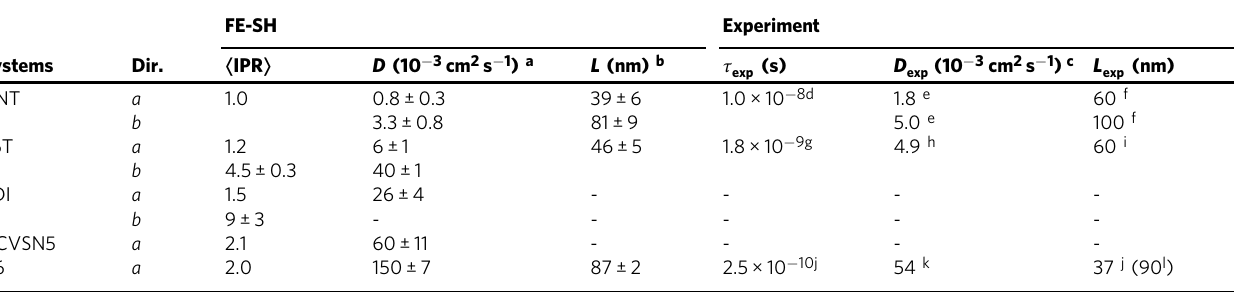
Table 2 Wavefunction delocalization ( 〈 IPR 〉 ), exciton diffusion constants ( D ), and exciton diffusion lengths ( L ).